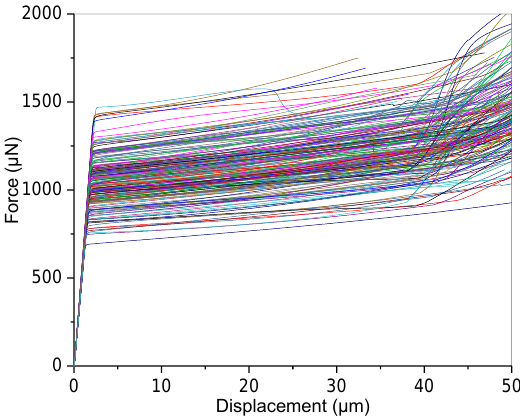
Figure 6. The force-displacement curves of each model. The yield force and stiffness of each model are shown in Figure 7. Both the yield force and stiffness fluctuated with the simulation number, indicating that the geometry of cells influences the mechanical property of wood.